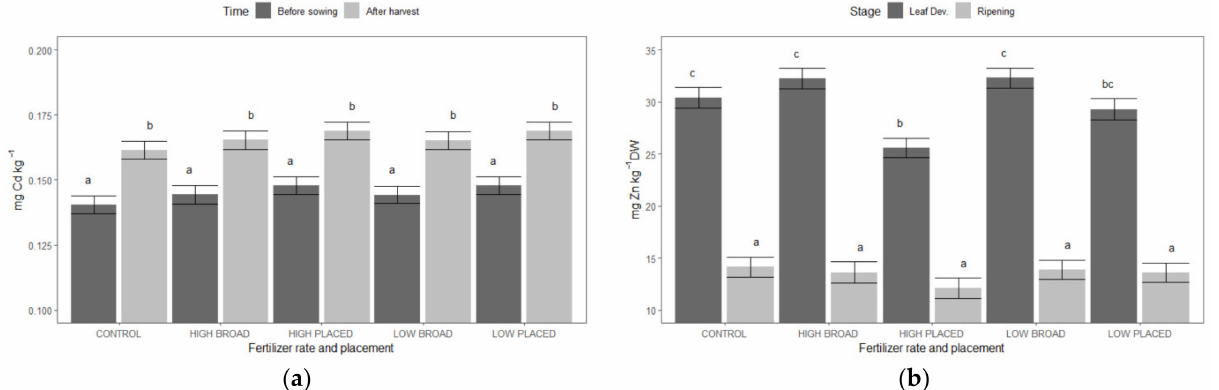
Figure 2. Means (bar plot) and standard error (error bar) for P treatments: ( a ) total Cd concentration in soil and ( b ) total Zn concentration in maize ( n = 80). Different letters indicate significant differences at p < 0.05 (Tukey’s